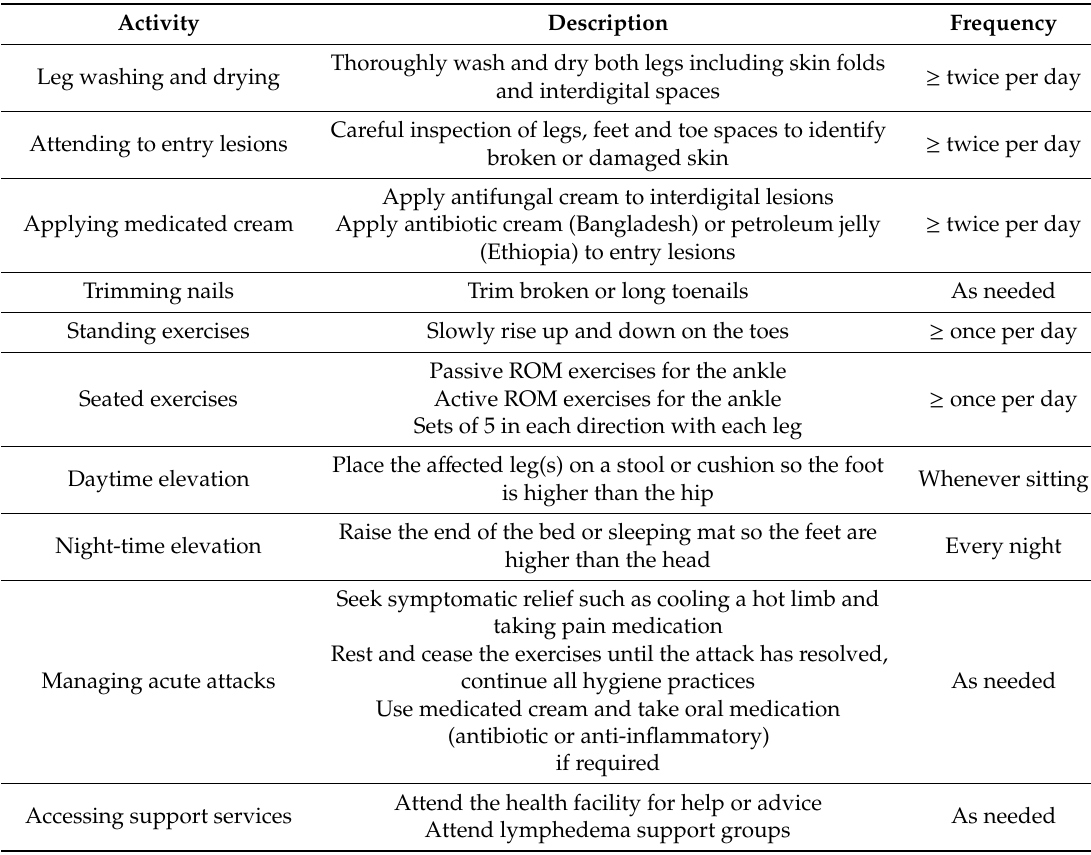
Table 1. Standard-care